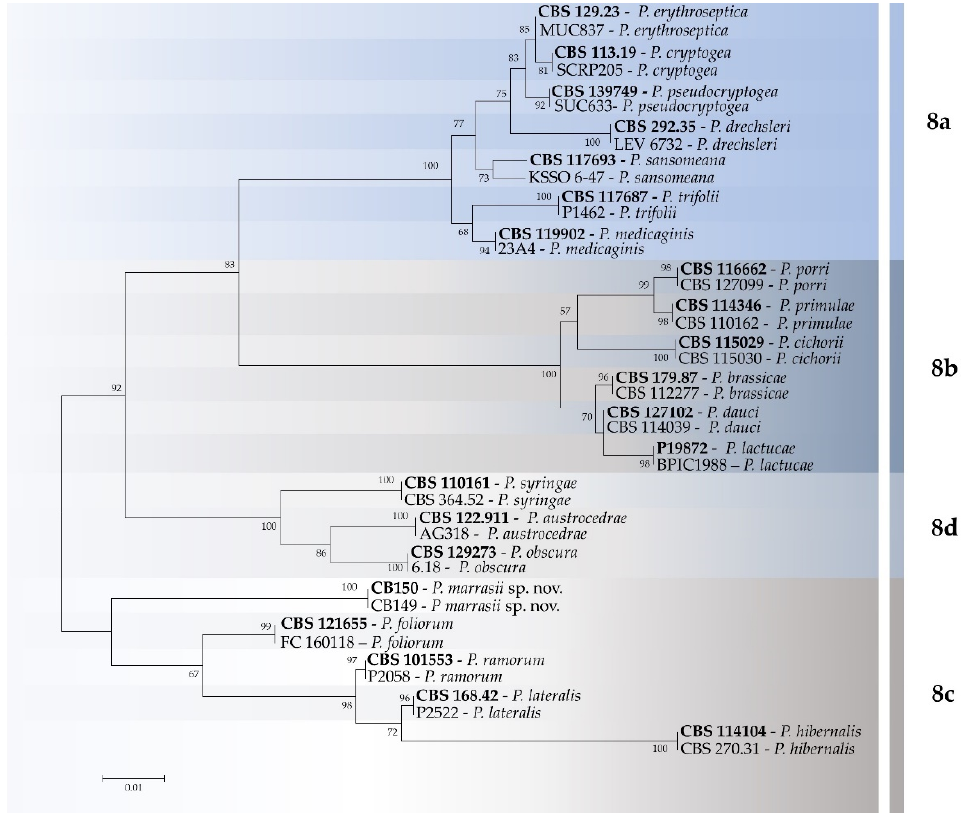
Figure 2. Maximum likelihood tree obtained from ITS sequences of Phytophthora species belonging to clade 8. Data are based on the General Time Reversible model. A discrete Gamma distribution was used to model evolutionary rate differences among sites. The tree is drawn to scale, with branch lengths measured in the number of substitutions per site. Bootstrap support values in percentage are given at the nodes. Ex-type cultures are in bold.